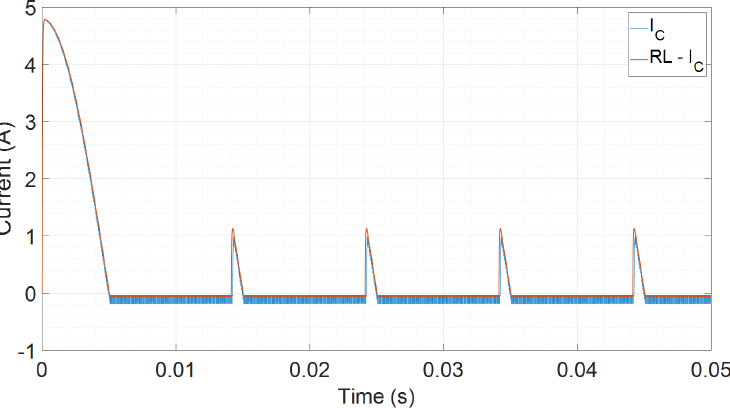
Figure 5. Current Waveform